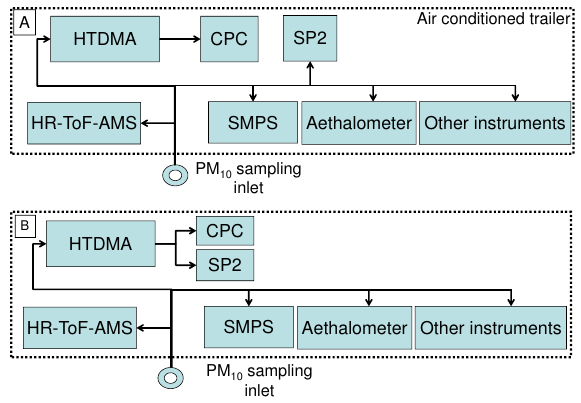
Fig. 3. Experimental setup during the majority of the measurement campaign (A) and during the period with coupled HTDMA-SP2 setup ( B : 30–31